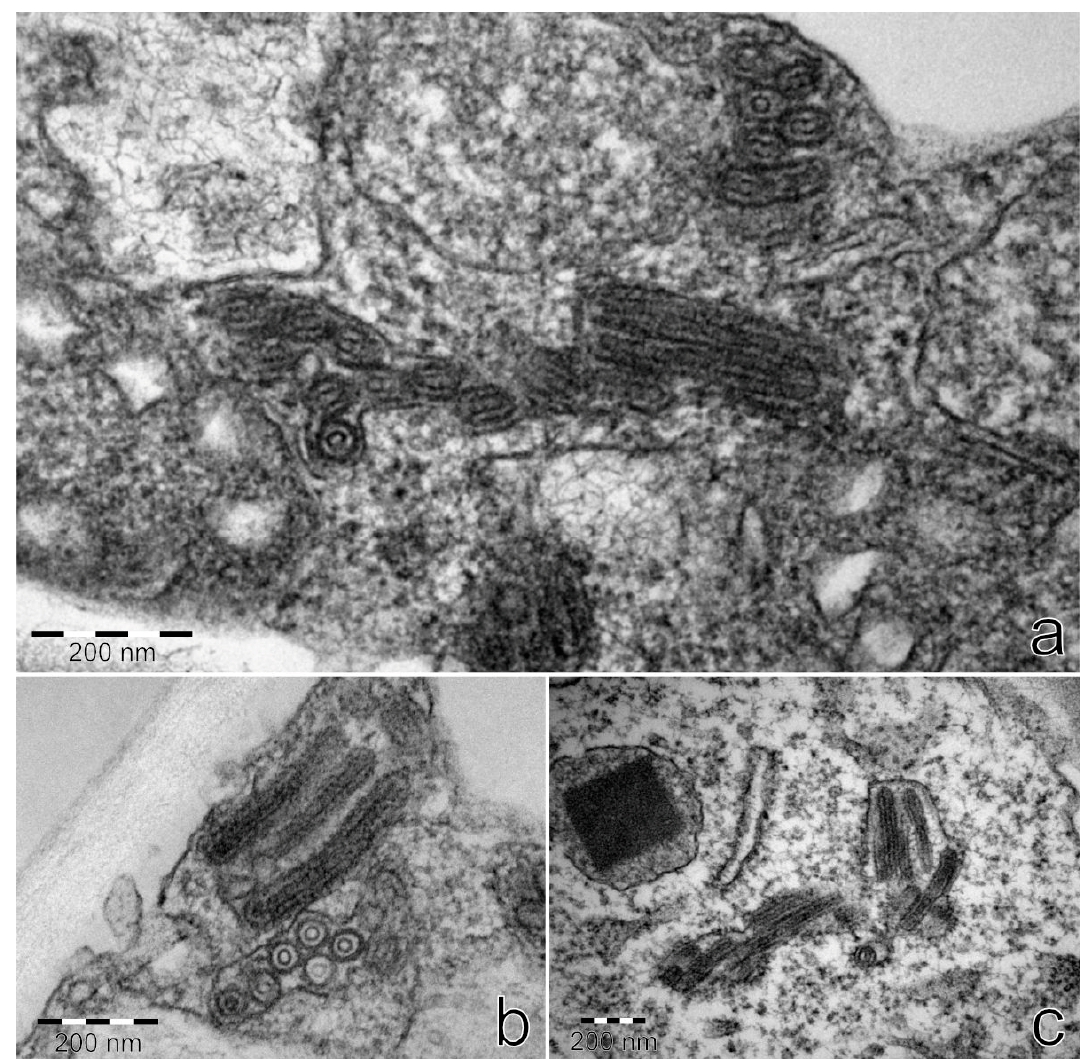
Figure 13. Bacilliform rhabdovirus-like particles in cytoplasmic inclusions on ultrathin sections from N. benthamiana ( a , b ) and N. occidentalis 37B ( c ) plants infected with the StrV-1-1/2017(B) genotype.